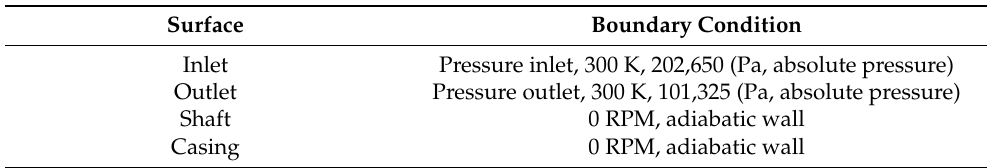
Table 2 lists the boundary conditions of the numerical analyses. The pressure and outlet were used, and the pressure ratio was 2.0. The numerical study was performed under adiabatic-wall conditions, with ideal gas at 300 K, and in stationary states. Table 2. Boundary conditions of the numerical analyses.